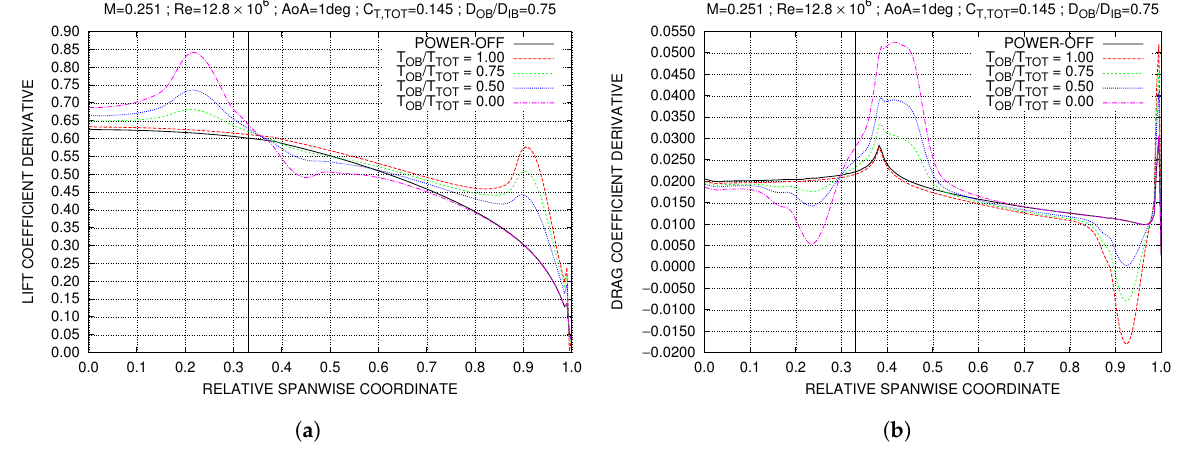
Figure 16. Wing spanwise loading with IB and OB propellers in climb conditions at constant total thrust: ( a ) lift coefficient derivative; ( b ) drag coefficient derivative.